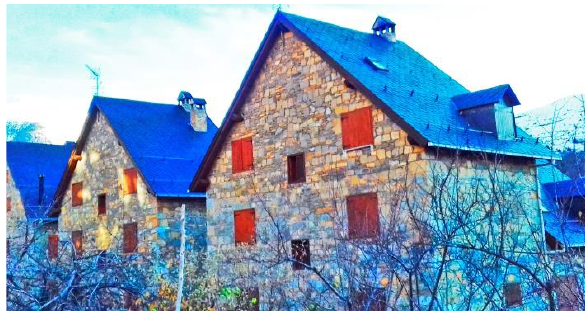
Figure 4. Stony, low embodied energy. Photo: César Arguedas.